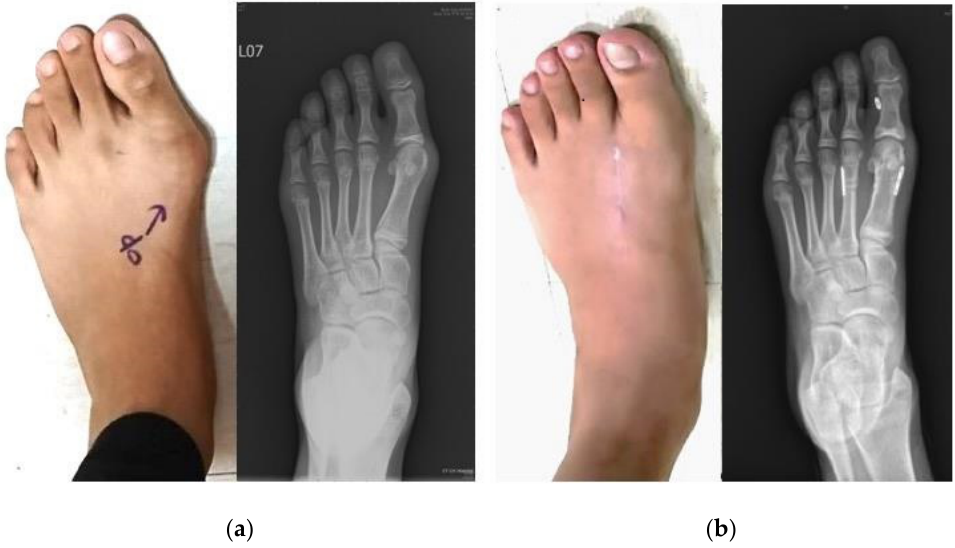
Figure 4. Clinical appearance and radiography (anteroposterior view) of the left foot. ( a ) Preoperative standing weight-bearing view and ( b ) 1-year follow-up postoperative standing weight-bearing view.